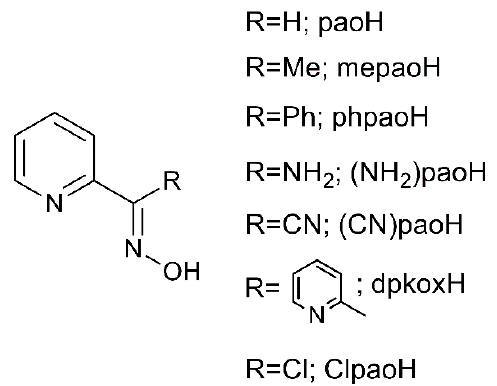
Figure 1. Structural formulae of some 2-pyridyl oxime-type ligands.